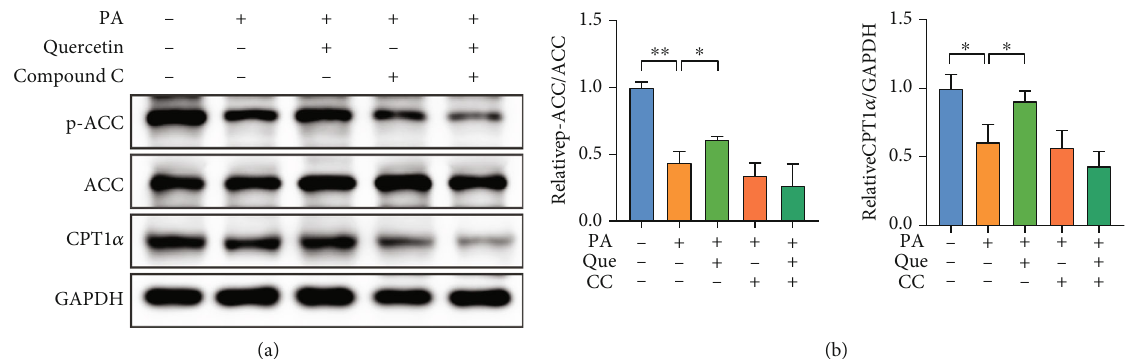
Figure 9: Quercetin increases fatty acid β -oxidation by regulating AMPK/ACC/CPT1 α signaling in PA-induced HepG2 cells. (a) The protein expression levels of p-ACC, ACC, and CPT1 α were examined by Western blot analysis in HepG2 cells ( n = 3 ). (b) The gray value analysis of p-ACC, ACC, and CPT1 α . Data are presented as the mean ± S : E : M . ∗ P < 0 : 05 and ∗∗ P < 0 : 01